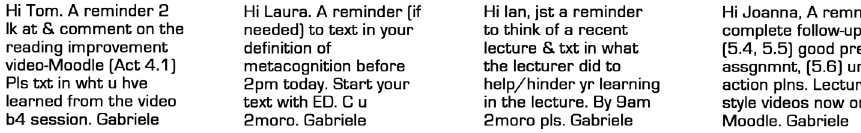
Figure 5. Examples of text messages sent to students.